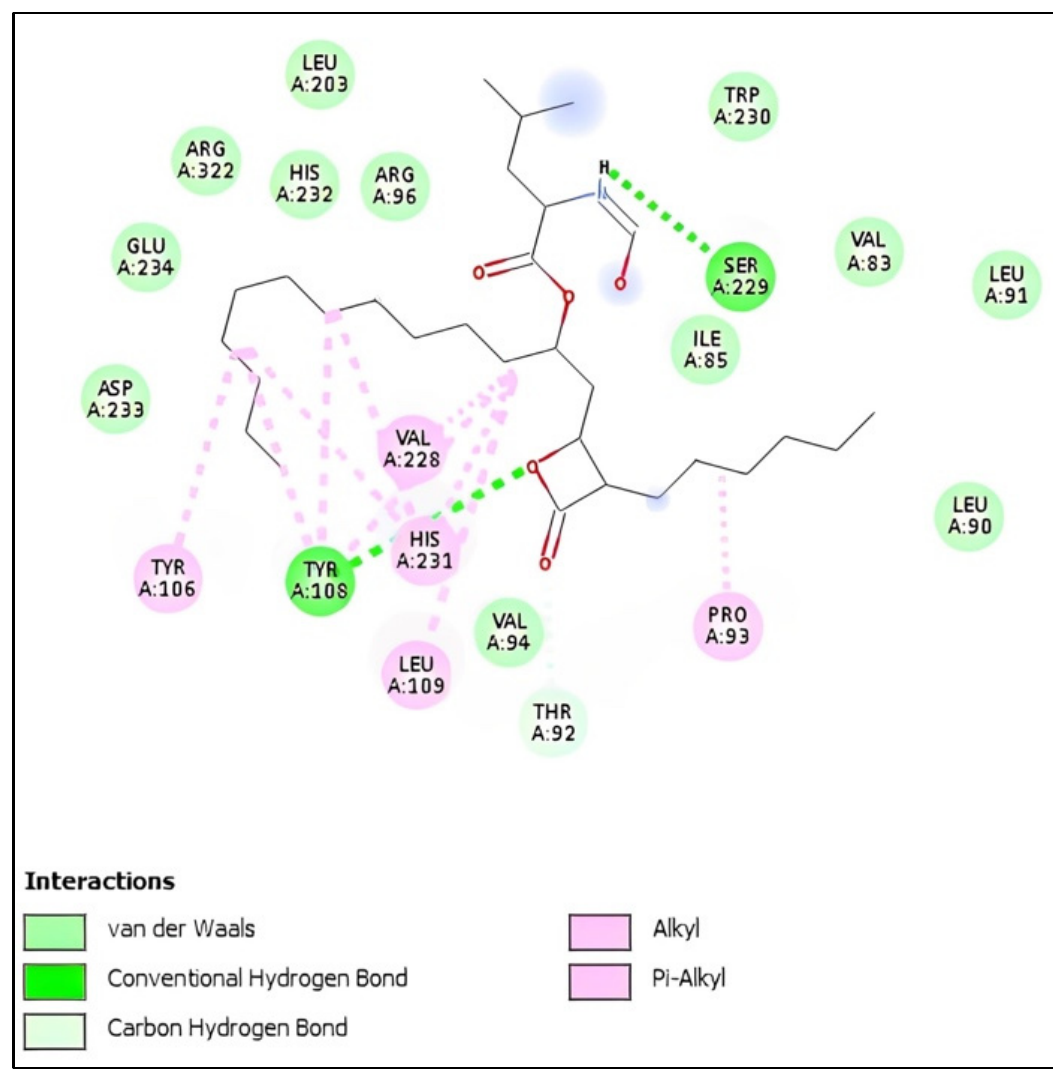
Figure 9. Docking visualisation of the interaction in 2D between Caloxanthone B ( A ) and Orlistat ( B ) with FTO by molecular docking simulation and residues of the binding site.